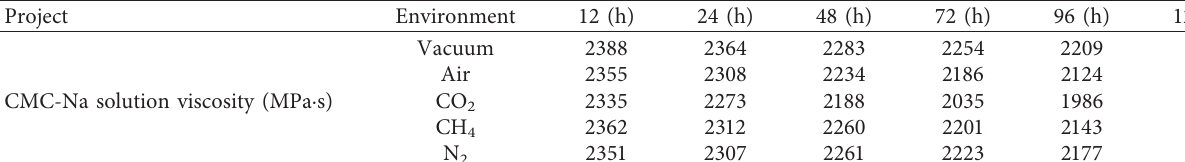
Table 3: Temporal changes in the viscosity of a CMC-Na solution made with distilled water. Project